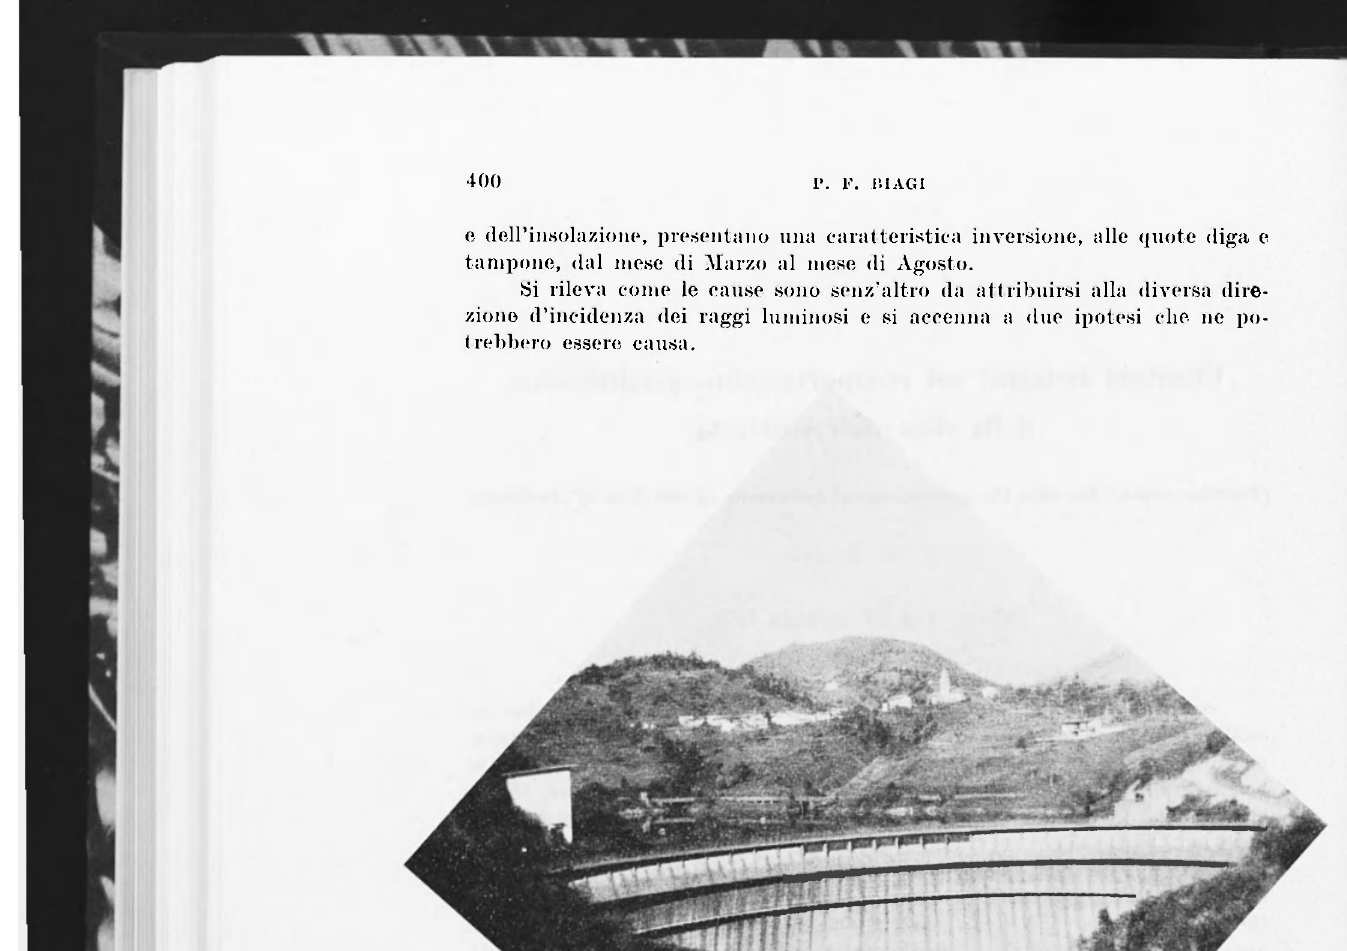
Pig. 1 - Diga dell'Ambiesta, vista da